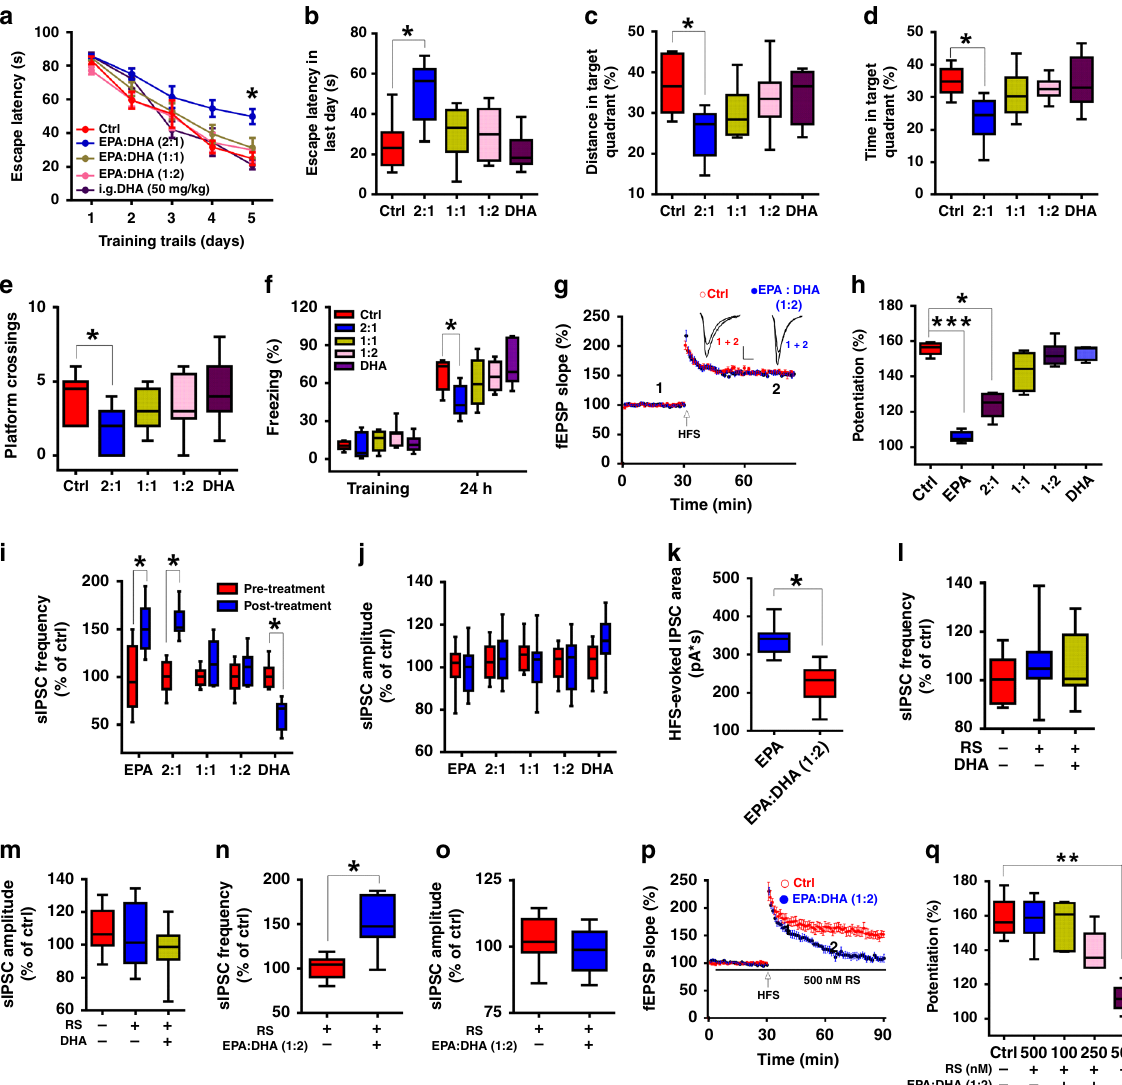
Fig. 8 DHA prevents EPA-induced impairments via the 5-HT 2C R. a , b Mean escape latencies across 5 consecutive days ( a ) or on the last day ( b ) during the MWM training (n = 10 – 11 mice/group; a : repeated measures two-way ANOVA, F (4, 200) = 33.354, P = 0.048; b : one-way ANOVA, F (4, 47) = 33.456, P